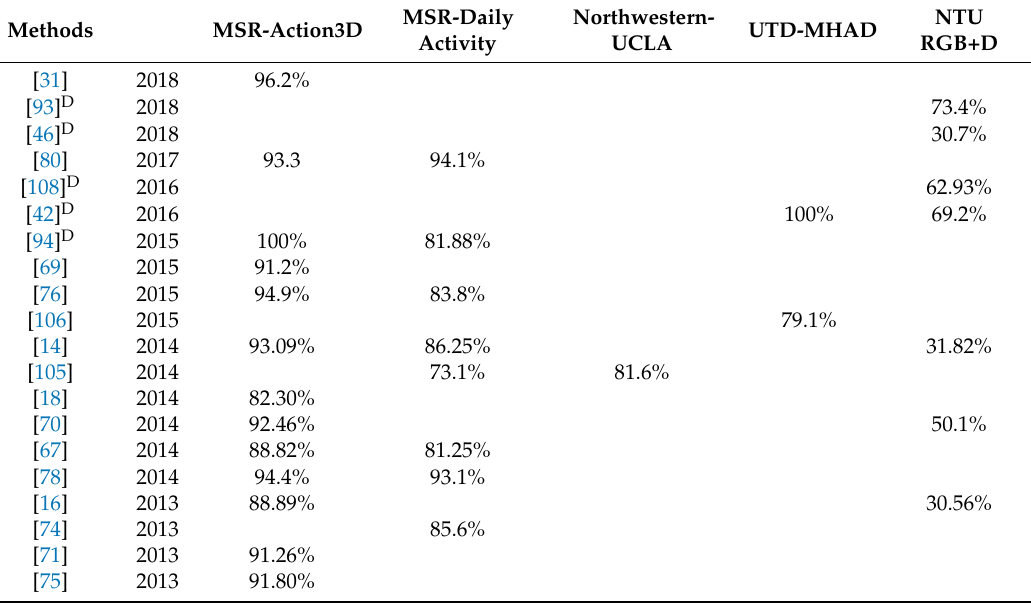
Table 3. Recognition accuracies of methods on RGBD (Red, Green, Blue Depth) and skeleton datasets. The superscript D indicates a deep learning-based